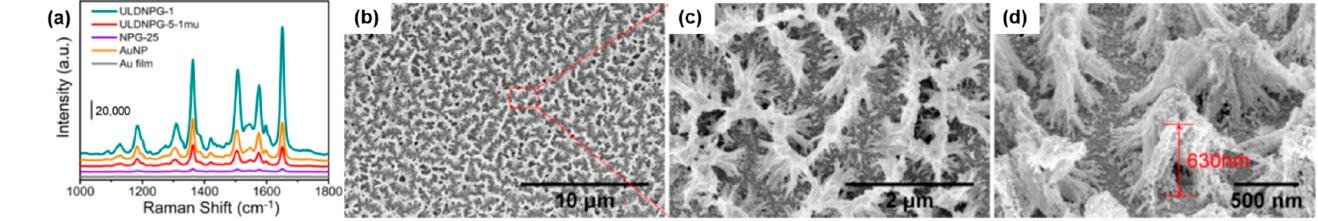
Figure 6. Electrochemical dealloying . ( a ) SERS spectra of rhodamine 6G (concentration is 1.0 × 10 − 6 M) obtained from ULDNPG − 1 (dealloyed Au 1 Ag 99 alloy thin film with 1 µm thickness), ULDNPG − 5 − 1mu (dealloyed Au 5 Ag 95 alloy thin film with 1 µm thickness), AuNP array, NPG − 25, and Au film, respectively. ( b − d ) SEM images of ULDNPG − 1 prepared via electrochemical dealloying. ( a – d ) Reprinted with permission from ref. [76]. Copyright 2021 American Chemical Society.